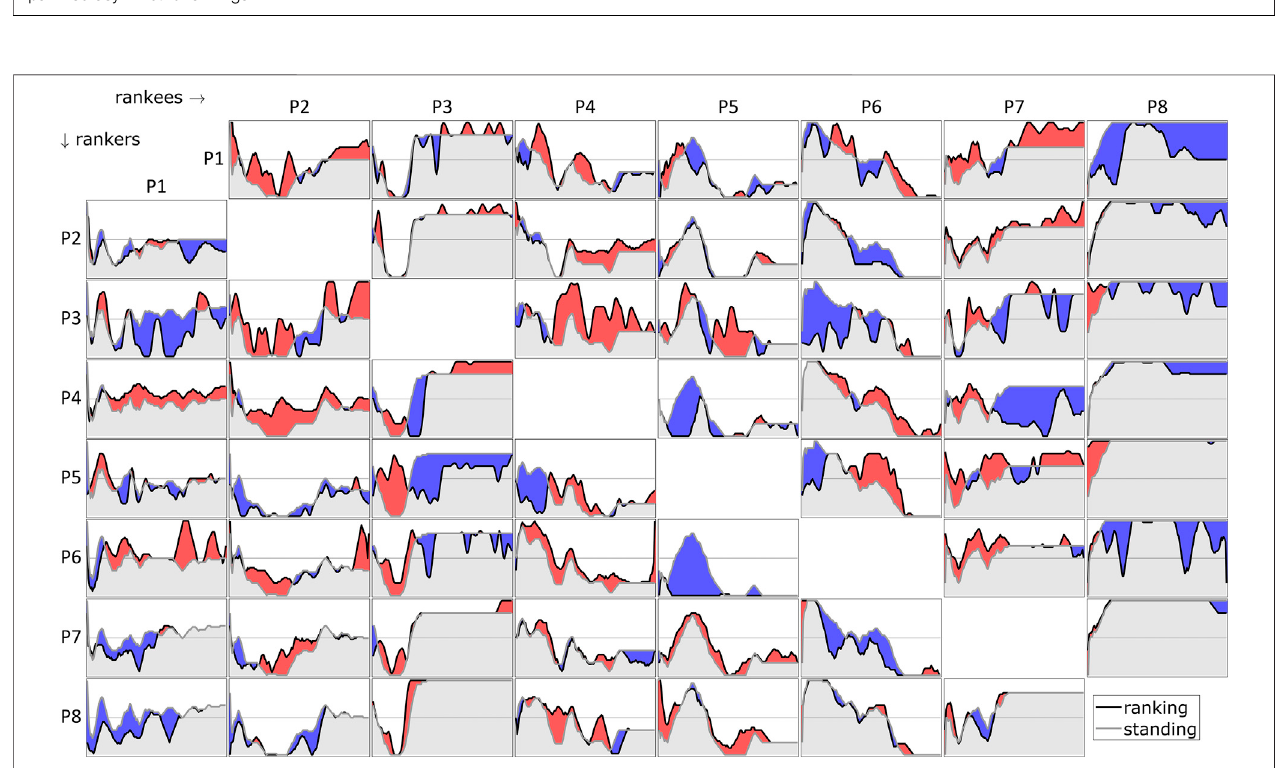
FIGURE5| Rankingtimeseries.Rowscorrespondtorankers,columnstorankees.Graylinesshowstandings(defaultrankingindrop-downlists),blacklinesshow selected rankings; red/blue indicate positive/negative differences between ranking and standing.